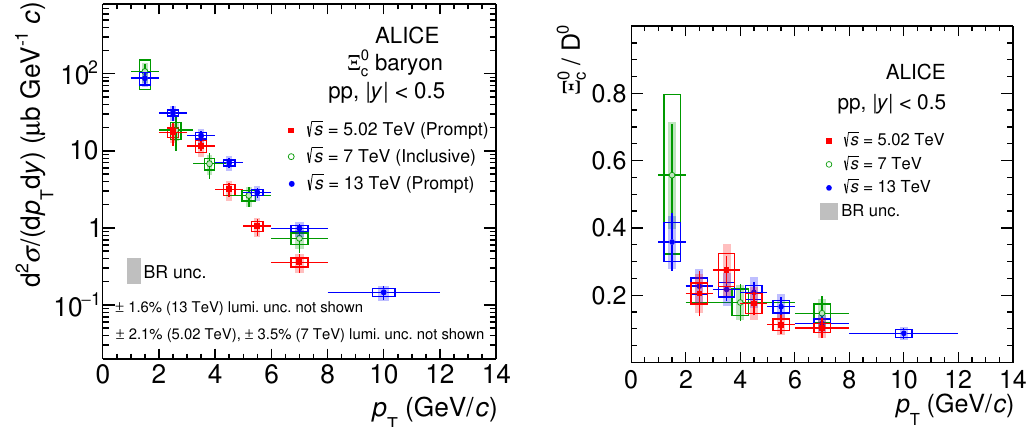
Figure 5 . Left panel: p T -differential production cross sections of prompt Ξ 0 baryons in pp collisions c √ √ at s = 5.02 TeV and 13 TeV [26] and of inclusive Ξ 0 baryons in pp collisions at s = 7 TeV [25] c with updated decay BR as discussed in the text. The uncertainty of the BR of the cross sections of √ prompt Ξ 0 baryons in pp collisions at s = 13 TeV is lower because it consists in the combination c of two different decay channels ( Ξ 0 → e + Ξ − ν e and Ξ 0 → π + Ξ − ) [26]. Right panel: Ξ 0 / D 0 ratio c c c √ √ measured in pp collisions at s = 5.02 TeV, compared with the measurements at s = 7 TeV [25] √ and s = 13 TeV [26]. The uncertainty of the BR of D 0 and Ξ 0 are shown as shaded boxes. c √ , indicating a hardening of cross sections at different s values increases with increasing p T the p -differential spectrum with increasing collision energy. This behaviour is consistent T √ with that observed for the D-meson and Λ + -baryon cross sections at s = 5.02, 7 and c 13 TeV [2, 3, 16, 18, 19], and with the expectations from pQCD calculations [13, 14]. The visible cross section is computed by integrating the p -differential cross section in the p T T interval of the